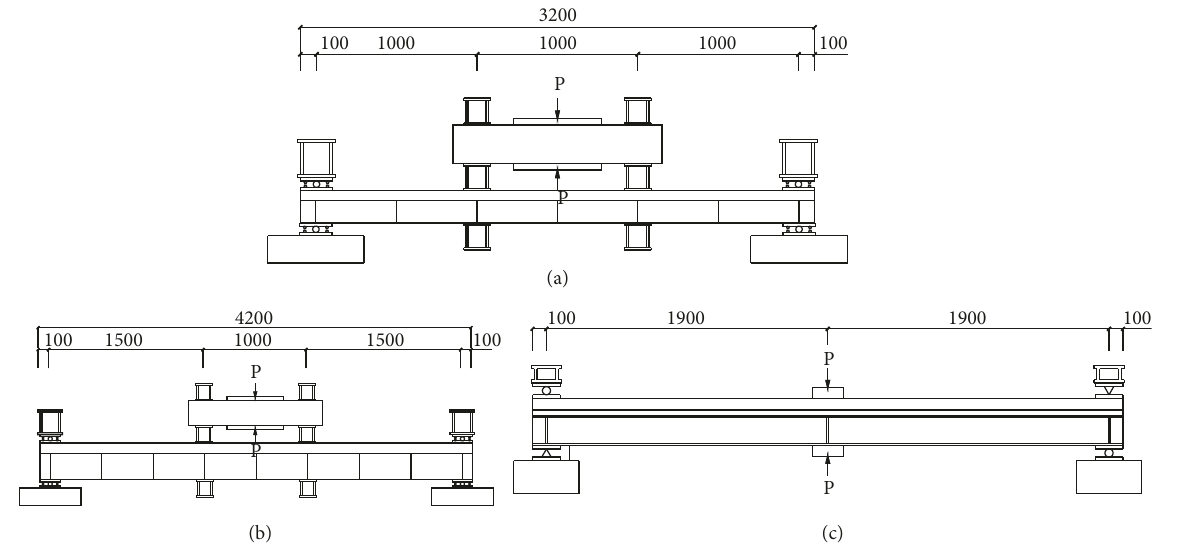
Figure 3: Experimental setup for all specimens: (a) SCB1 ∼ 8, (b) SCB9 ∼ 13, and (c) SCB14 ∼